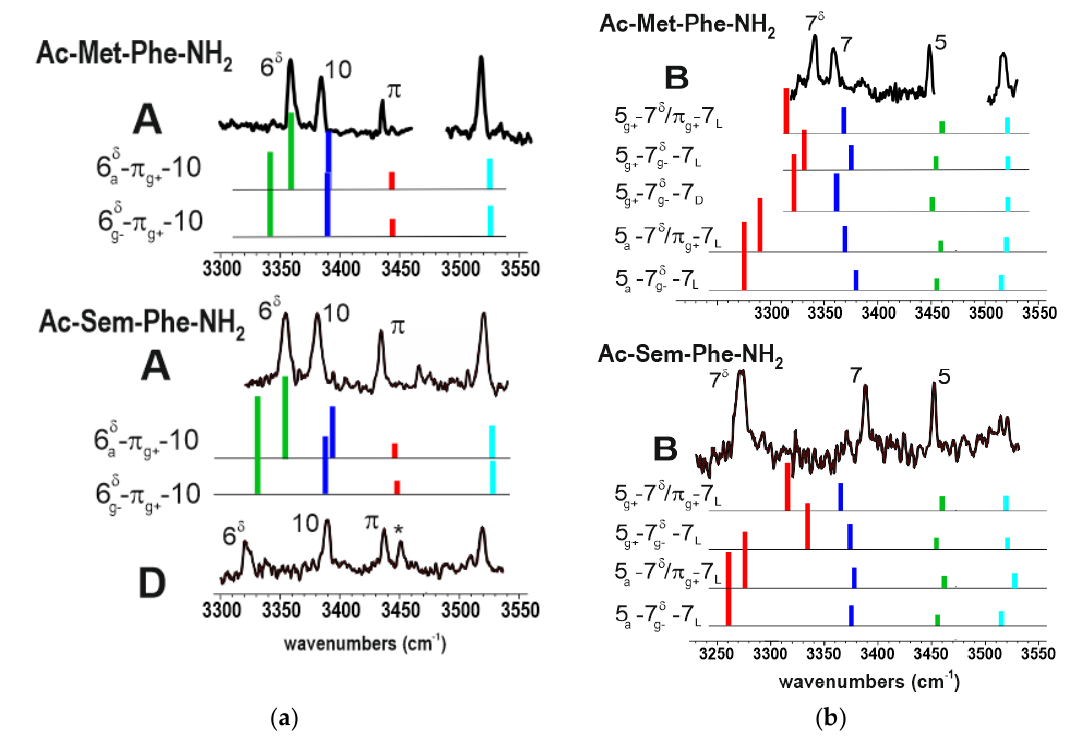
Figure 4. ( a ) left panel: IR/UV double resonance spectra of folded conformers observed in the Sem-Phe and Met-Phe sequences, compared to the theoretical spectra (colored sticks) of selected best matching, low energy conformations. The comparison illustrates the similarities of the 6 δ H-bonds in these sequences; ( b ) right panel: same pictures for the semi-extended conformers B, emphasizing the apparent differences in the 7 δ H-bonds between the two sequences. See text for assignment.